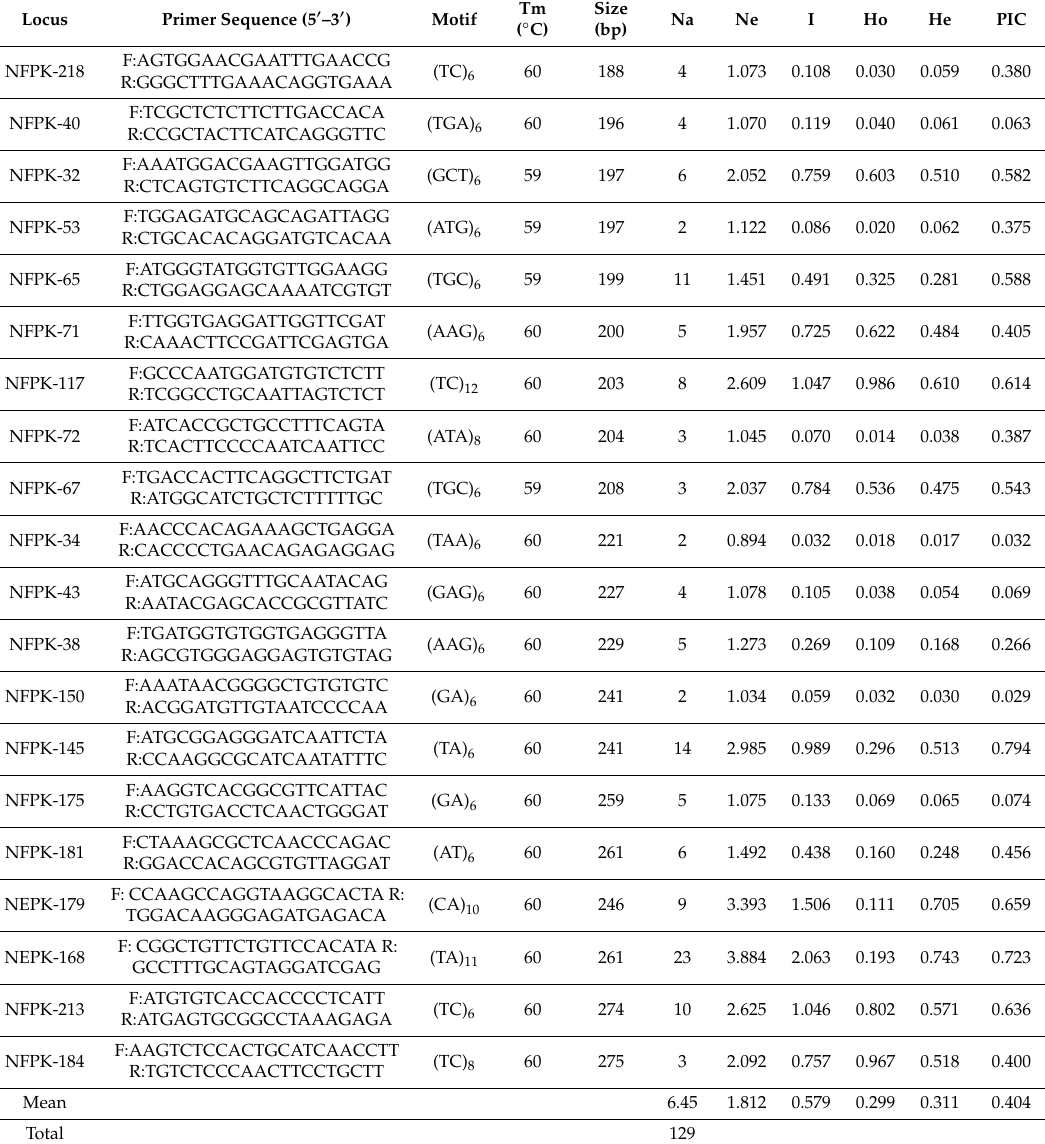
Table 4. Characteristics of 20 EST-SSR loci in 80 unique genotypes in Pinus koraiensis .